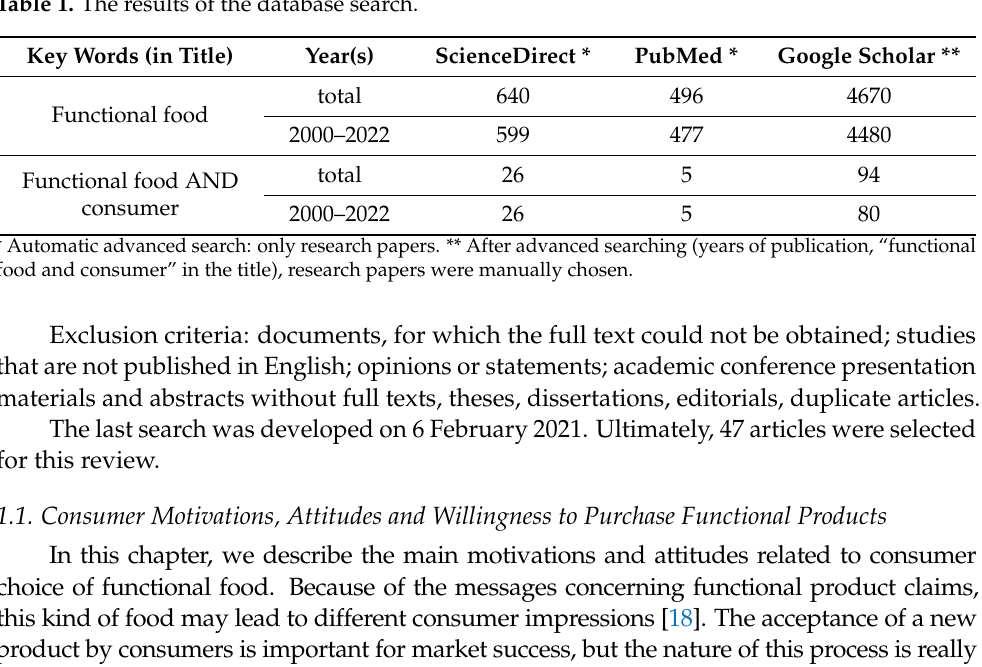
Table 1. The results of the database